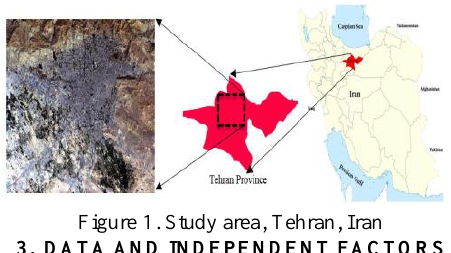
Figure 1. Study area, Tehran,